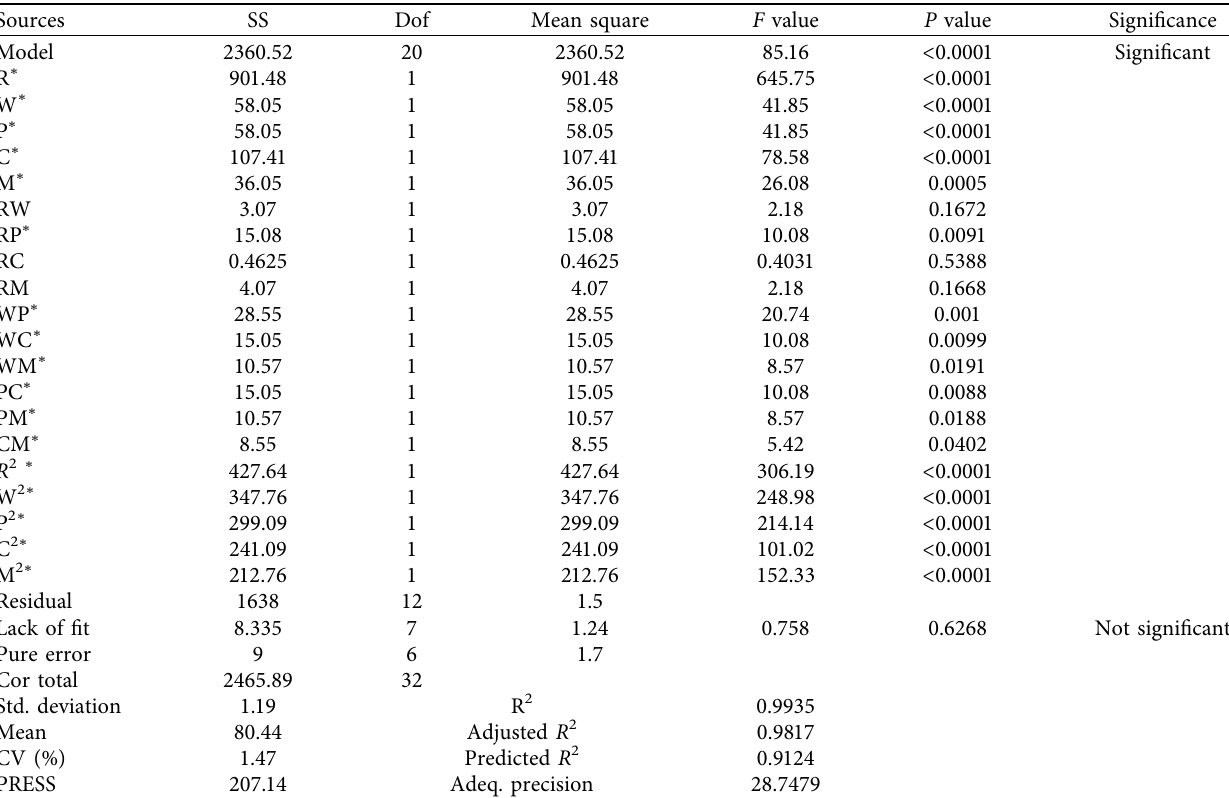
Figure 6: Impact of processing factors on microhardness of AA6063 and AA 5154 (a) R, (b) W, (c) P, (d) C, and (e) M. Table 8: Microhardness ANOVA